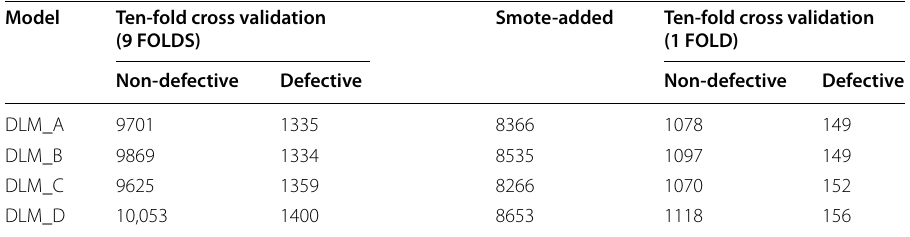
Table 12 Quantities of devices (defective and non-defective) used for the ten-fold cross validation procedure plus the number of SMOTE-added devices for the minority class